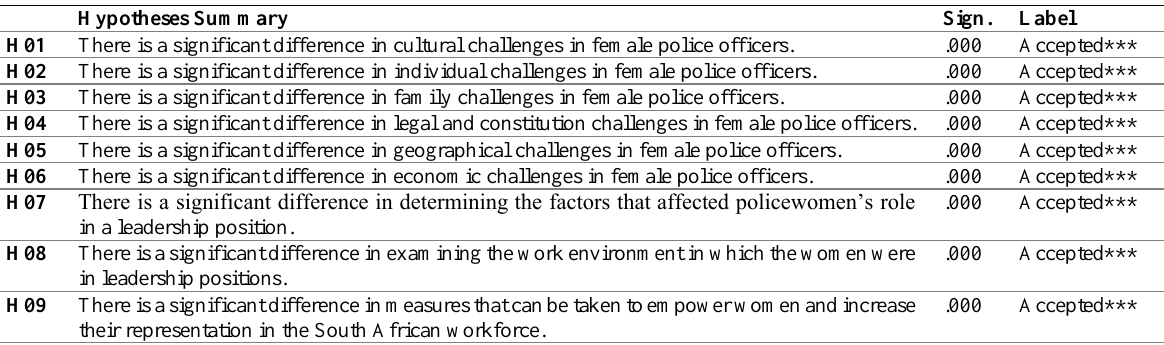
Table 4: Hypotheses Summary